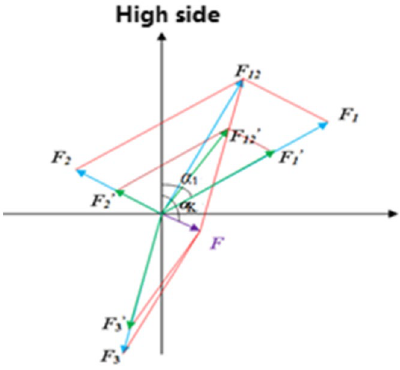
Fig. 7 Three pad forces adjusted to achieve the required steering force F